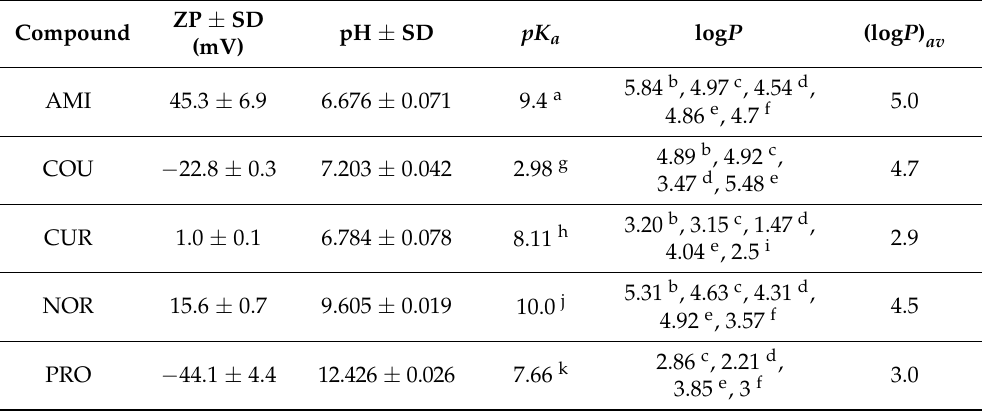
Table 3. The results of the zeta potential and pH measurements of the re-dispersions (in antisolvent) of the particles of the end dispersions of protocol No. 1 together with the values of pK a , log P and ( log P ) of the compounds. av